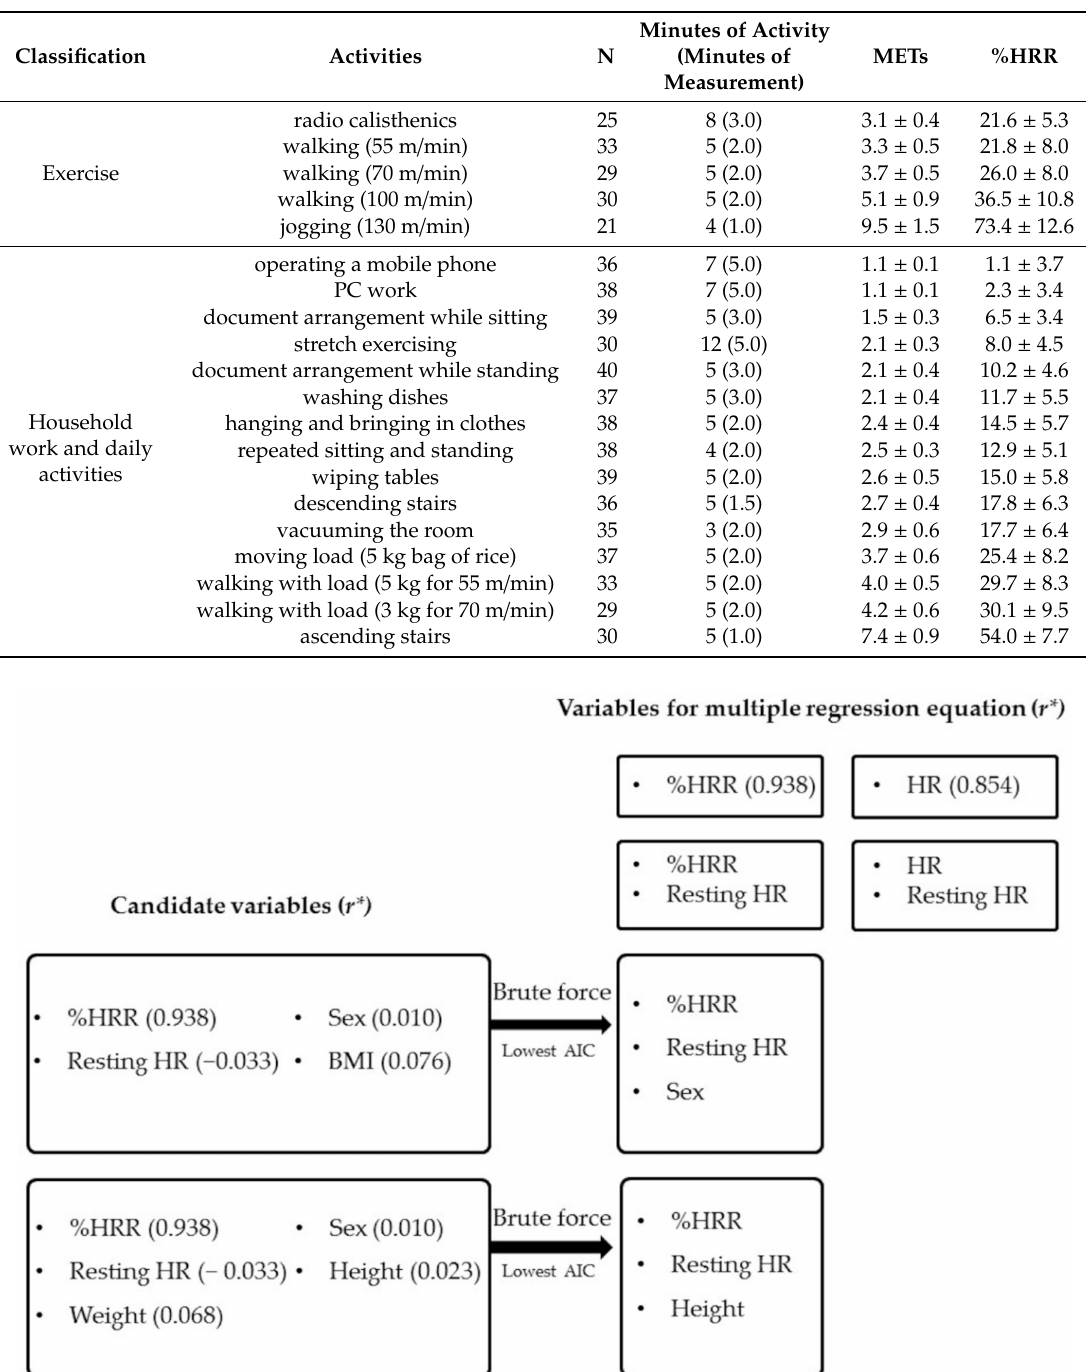
Table 2. Measured METs and %HRR of 20 activities.